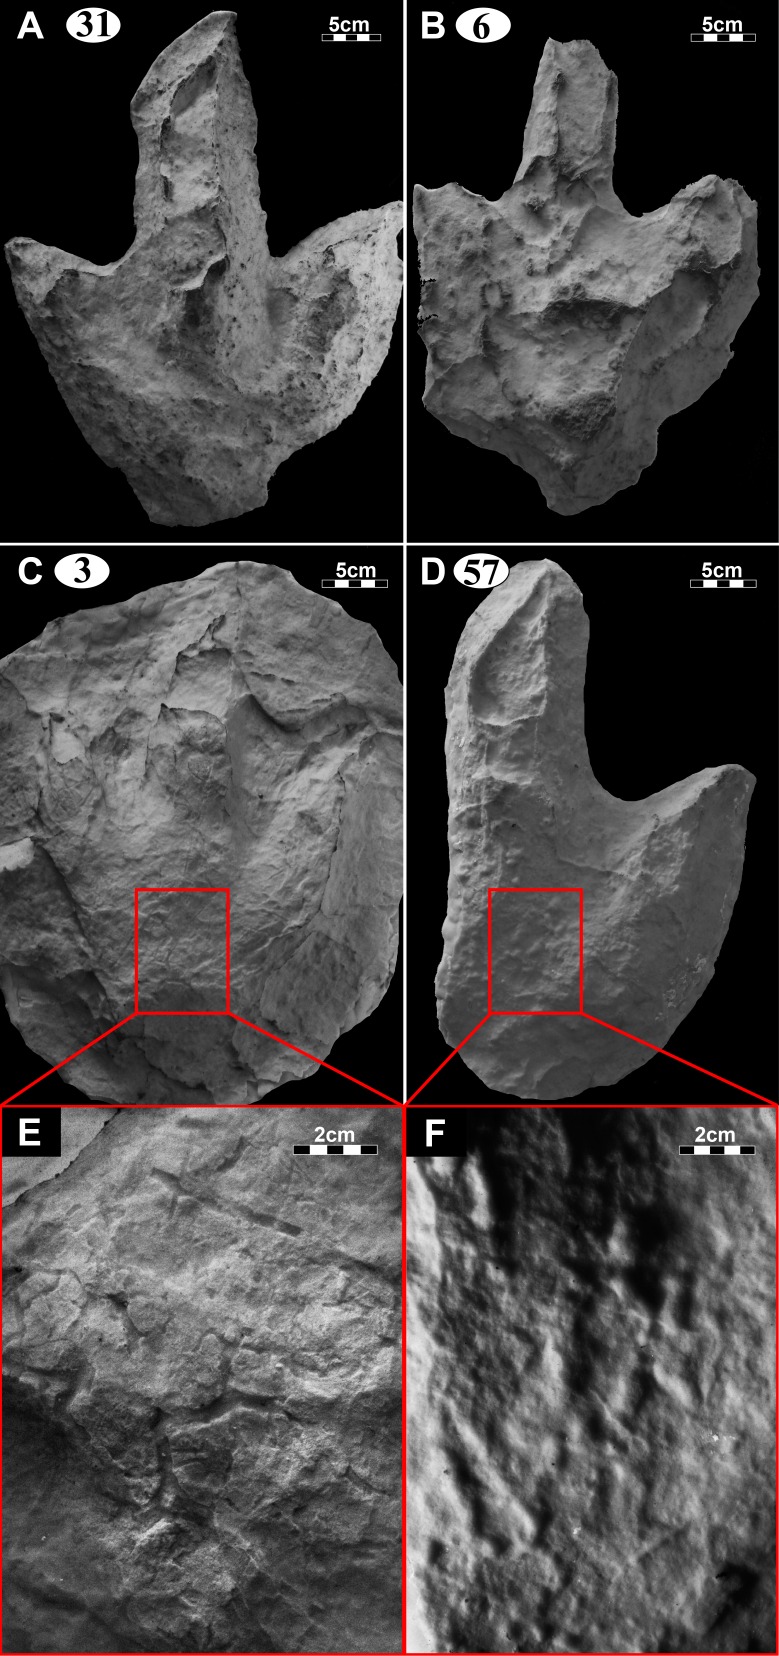
Casts of the best preserved tracks at the Mafube dinosaur track site.(A) Cast of track #31 on Surface I. (B) Cast of track #6 on Surface I. (C) Cast of track #3 on Surface II, with corresponding close-up photograph (E) of the desiccation cracks. (D) Cast of track #57 on Surface III, with corresponding close-up photograph (F) of the pitted texture.